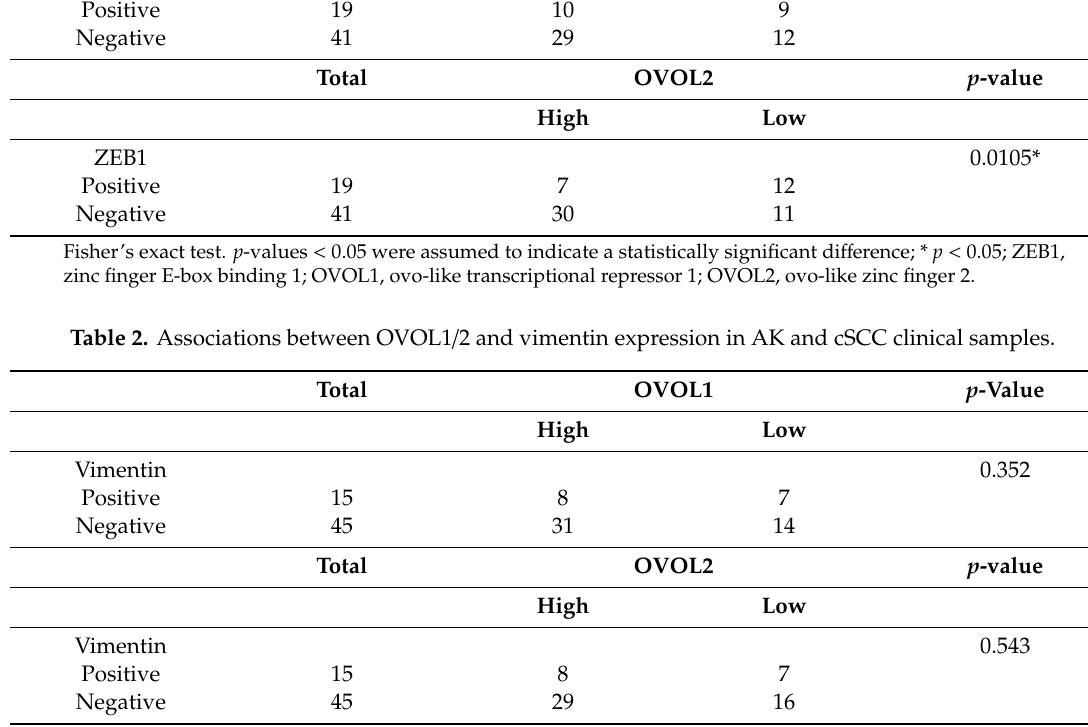
Table 1. Associations between OVOL1 / 2 and ZEB1 expression in AK and cSCC clinical samples. Total OVOL1 p -Value High Low ZEB1 0.245 Positive 19 10 9 Negative 41 29 12 Total OVOL2 p -value High Low ZEB1 0.0105*